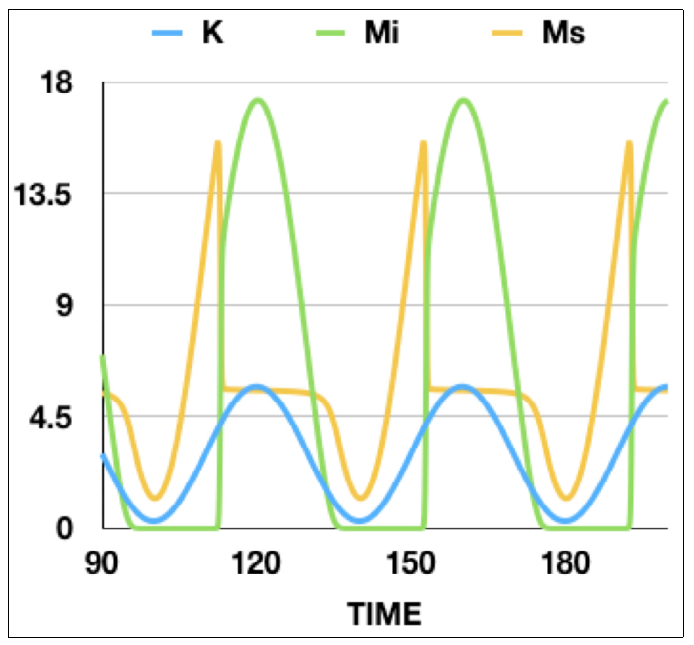
Figure4. numberofinfectedmice ( M i ) ,susceptiblemice ( M s ) andcarryingcapacity K asafunctionof timefora=0.8,b=5,c=1, K 0 =3,m=0.8and ω =.1571. Thebehaviorofthesystemisperiodicintime. Figure 4. Number of infected mice ( M i ) , susceptible mice ( M s ) , and carrying capacity K as a function of Thisgraphputsinevidenceadiscontinuousincreaseinthenumberofinfectedmiceanddecreasein time for a = 0.8, b = 5, c = 1, K 0 = 3, m = 0.8, and ω = 0.1571. The behavior of the system is periodic in thenumberofsusceptiblemicewhenKisincreased. time. This graph presents evidence of a discontinuous increase in the number of infected mice and decrease in the number of susceptible mice when K is increased.